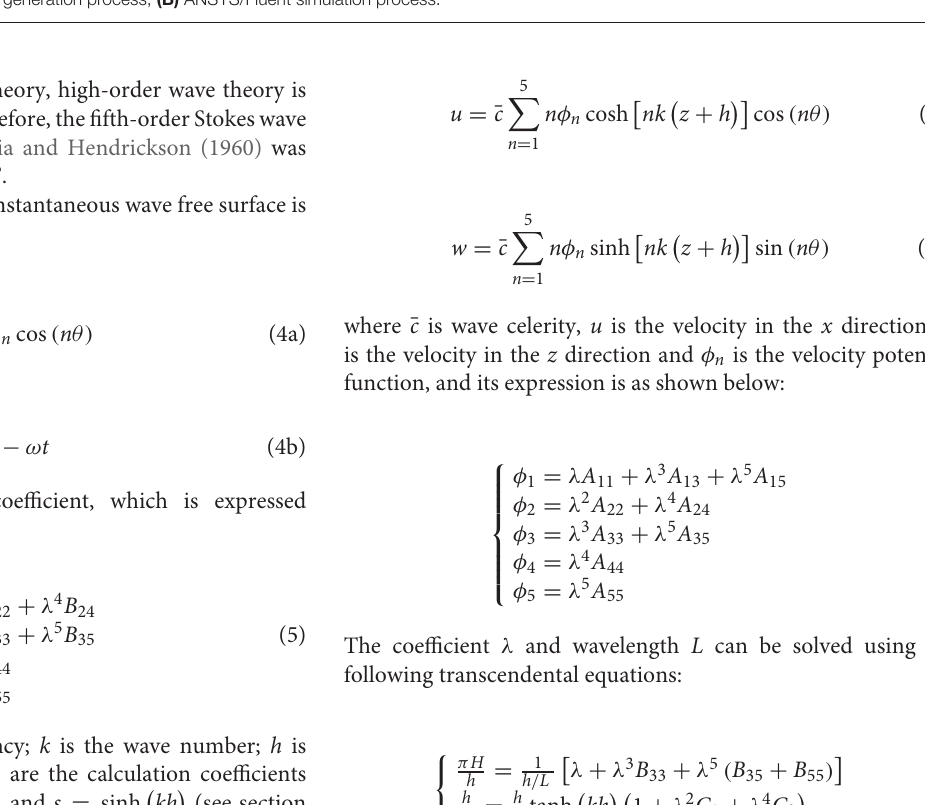
FIGURE 1 | The flowchart for (A) wave generation process; (B) ANSYS/Fluent simulation process.